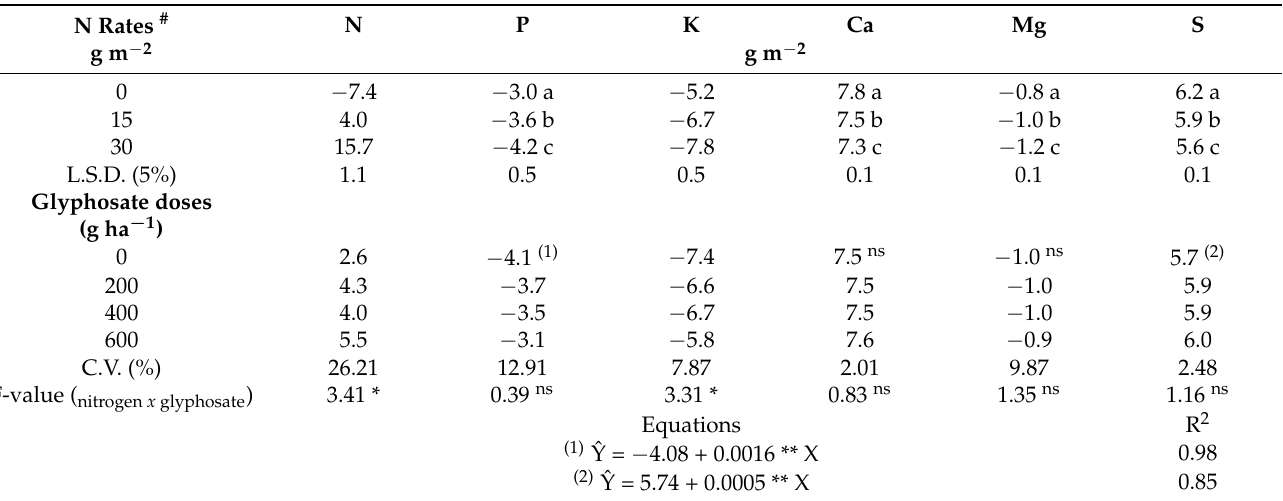
Table 4. The macronutrient balance obtained with the removal of leaves (“clippings “) and the application of N, Ca and S to the emerald grass, according to its treatments with nitrogen fertilization and doses of